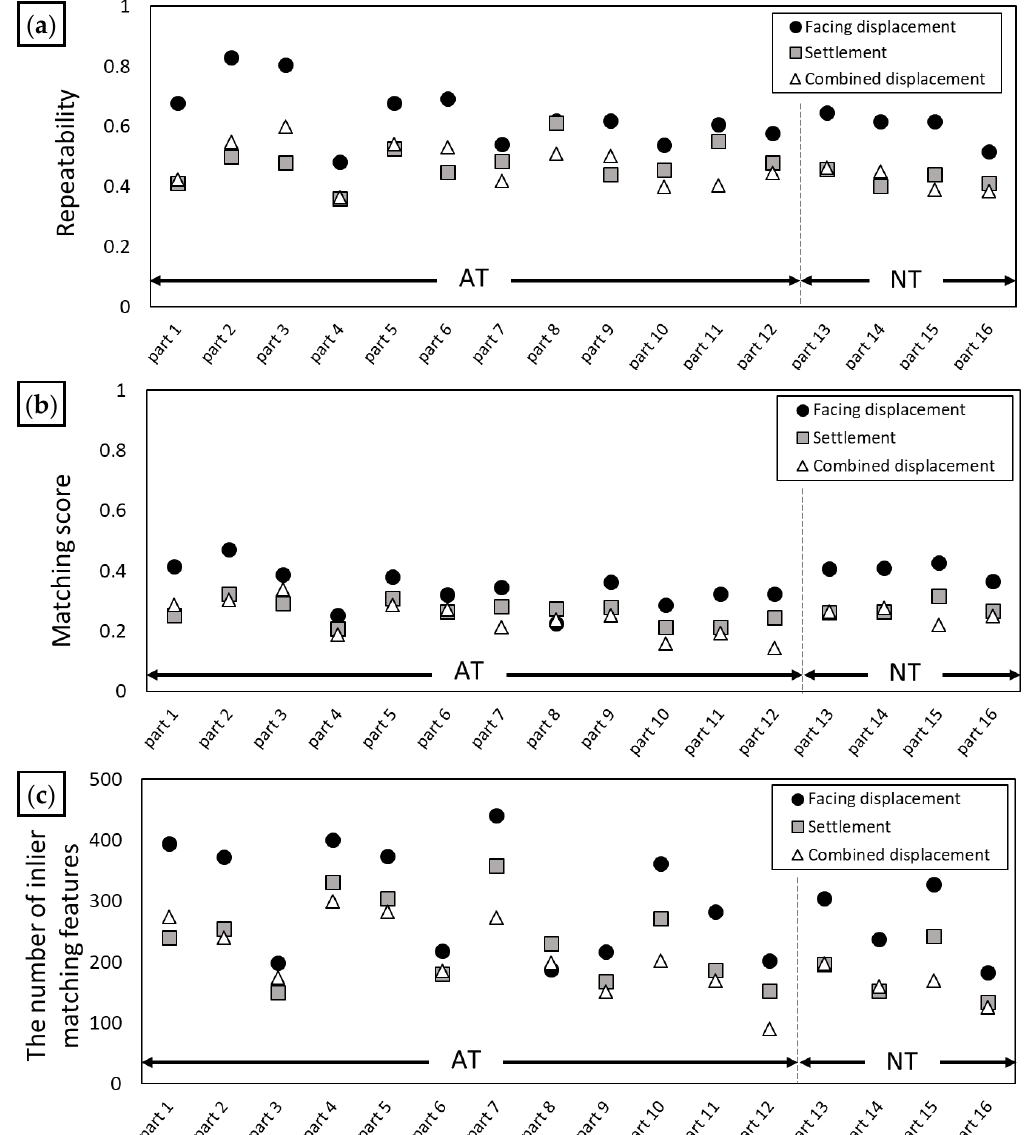
Figure 12. Comparison metrics in multiblock experiment with KAZE method (incidence angle = 60°). ( a ) Repeatability; ( b ) Matching score; ( c ) The number of inlier matching features.